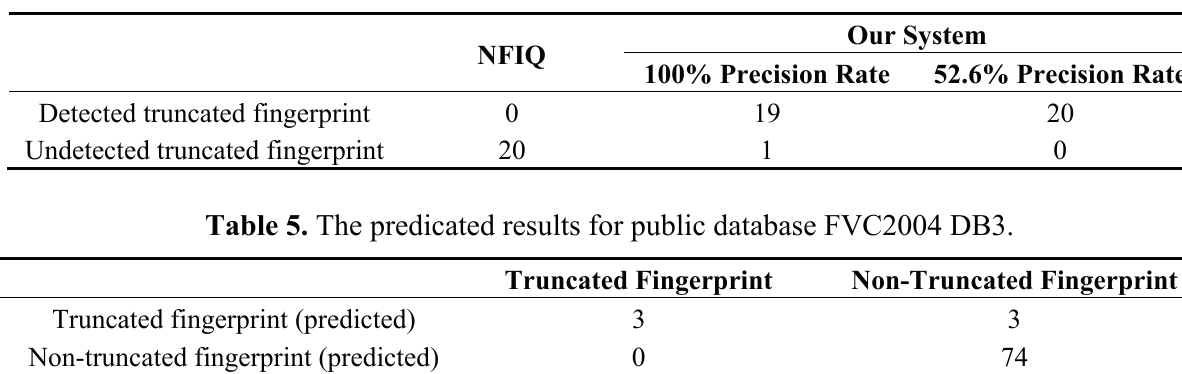
Table 4. The detection results for various systems. We defined that when NFIQ determined a fingerprint belonging to the level 4 (fair) or higher, the system classified the fingerprint as a normal fingerprint. On the other hand, when NFIQ determined the fingerprint at the level 5 (poor), the system classified the fingerprint as a truncated fingerprint.